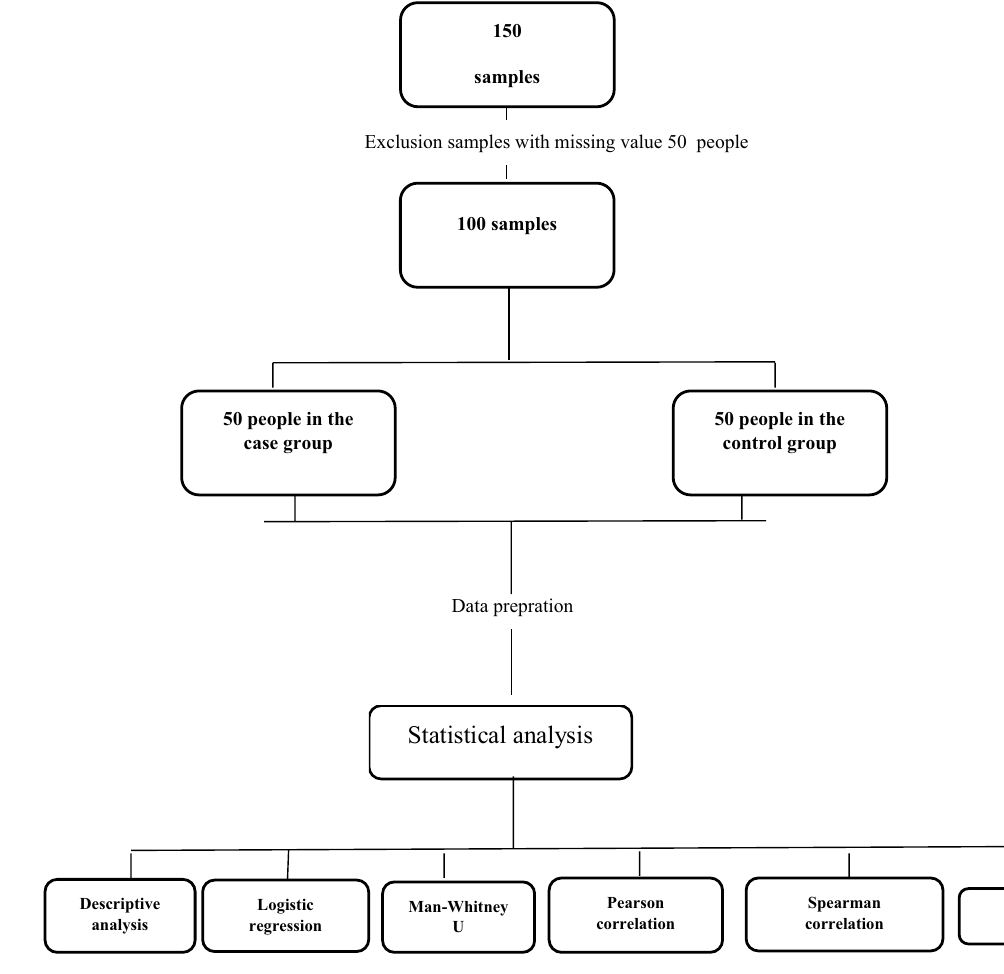
Figure 1. Study execution